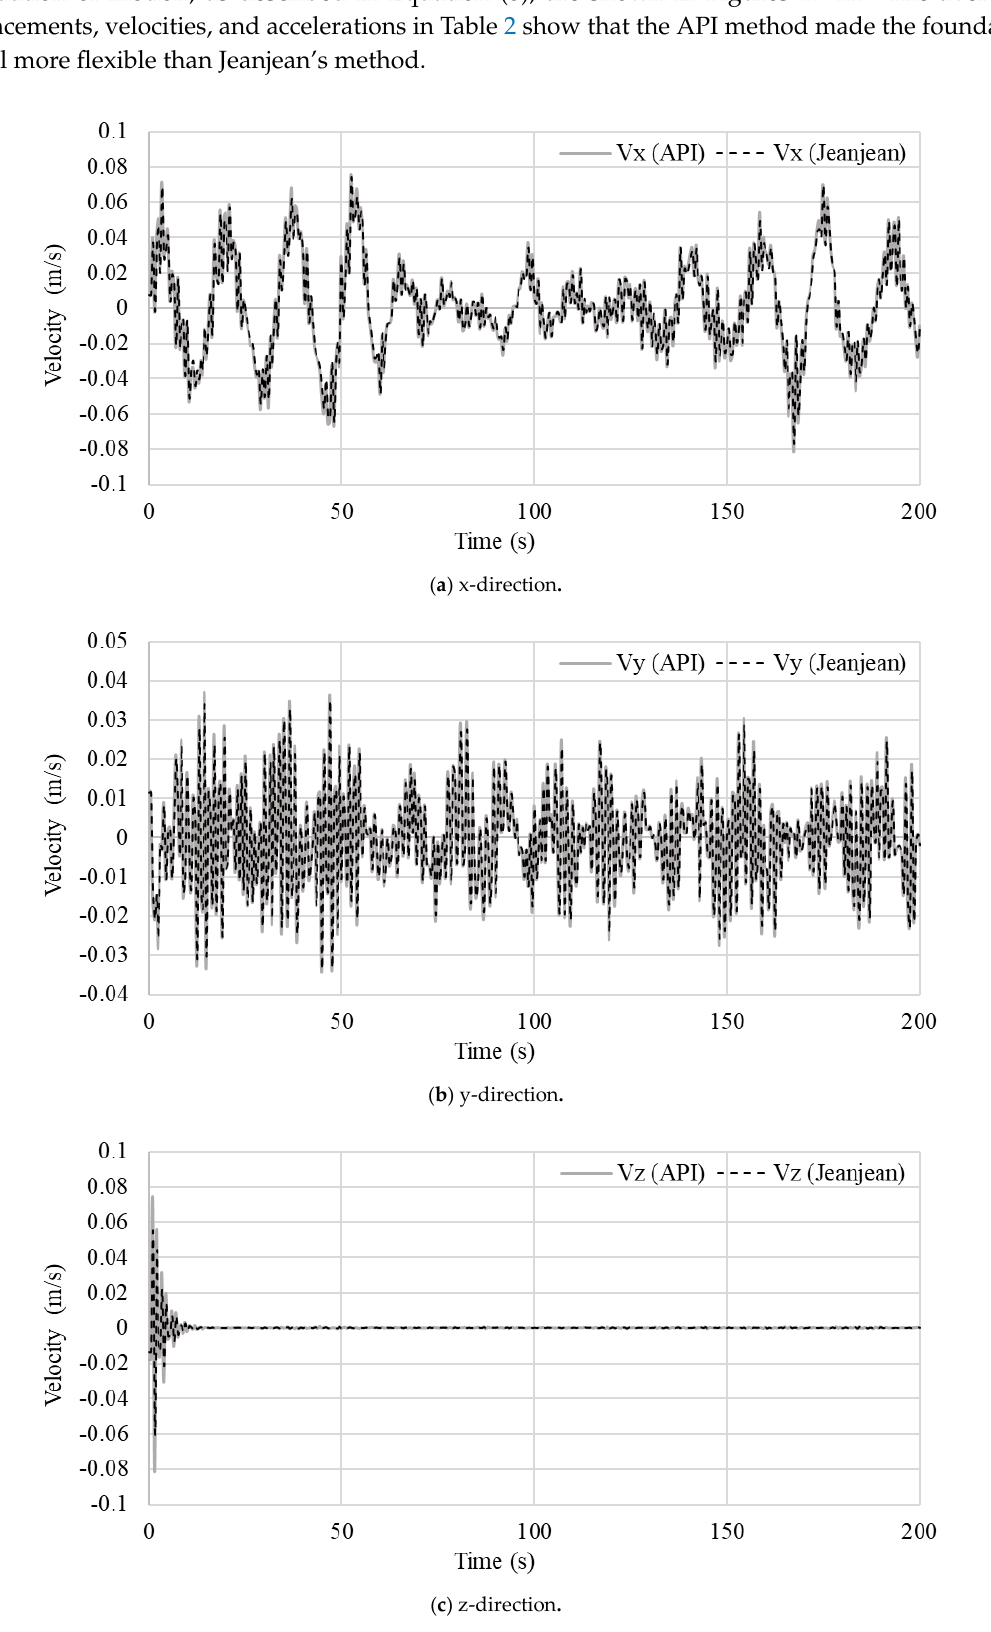
Figure 17. Velocity components at the interface.